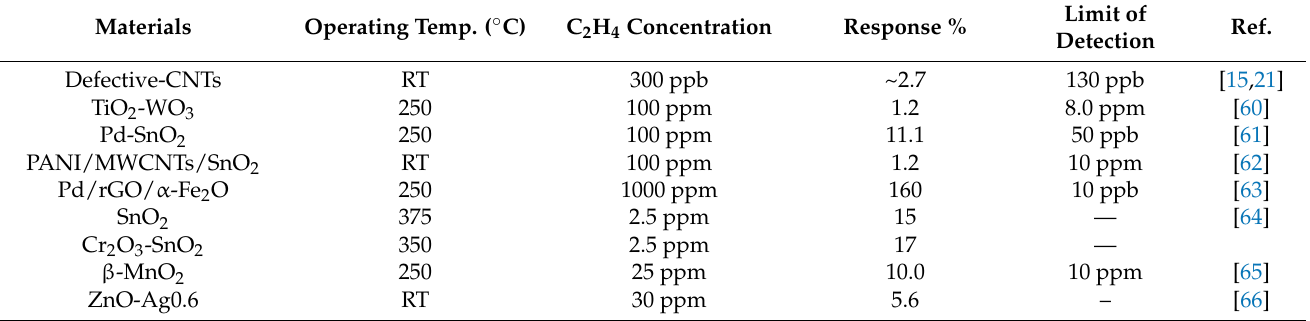
Figure 3. ( a ) Sensor response of a single banana as a function of the ripening days, detecting the ripening of banana over five days; ( b ) Repeated sensor signal (five cycles) for ( c ) different bananas at different ripening levels. Figures adapted with permission from [21]. Table 1. The most recent chemiresistive C 2 H 4 sensors reported in the